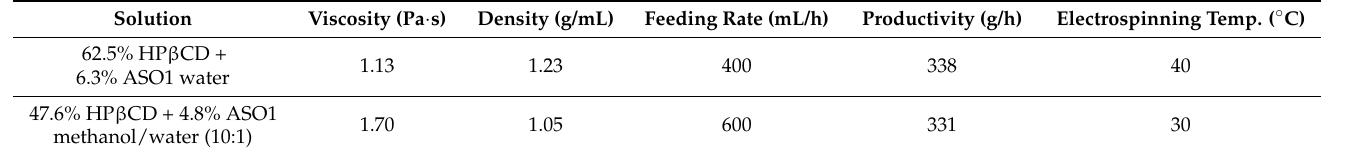
Table 2. Electrospinning parameters during pilot-scale HSES. The rotational speed of the nozzle was set to 40,000 rpm and 40 kV was applied to it in each experiment. Ventilation (120 m 3 /h) was used to collect the fibers in the cyclone.